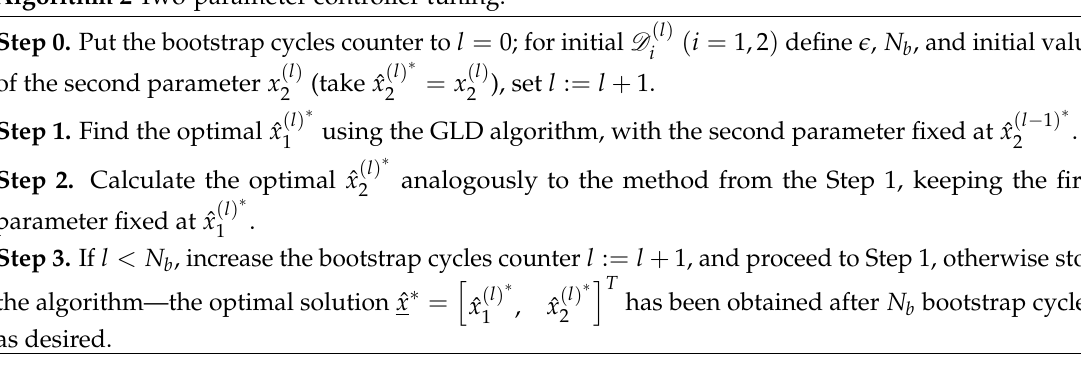
Algorithm 2 Two-parameter controller